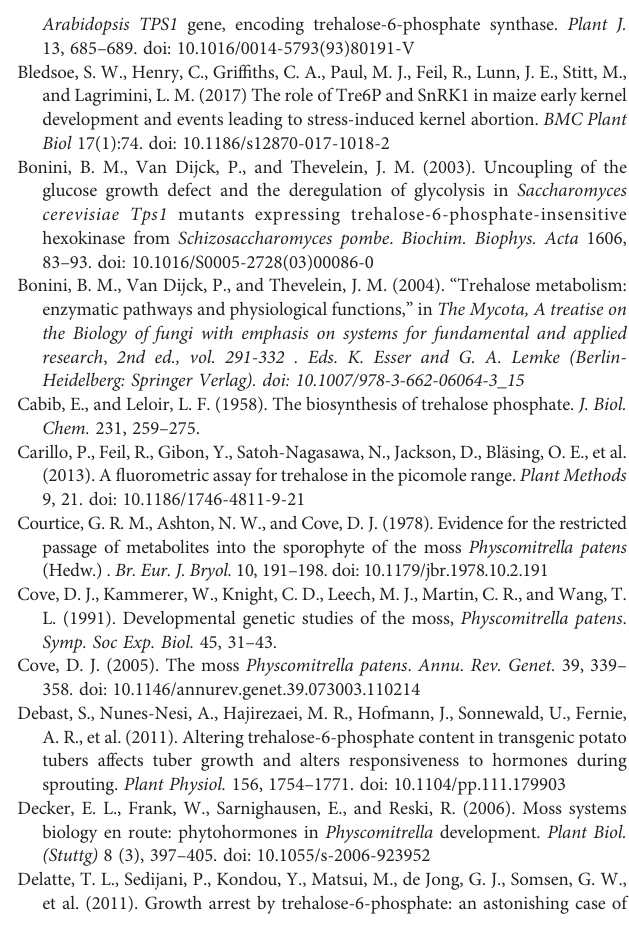
SUPPLEMENTARY TABLE 1 | List of primers used in the study. Abbreviations: FW (forward), RV (reverse), GSP (gene-speci fi c primer), CDS (coding sequence), qPCR (quantitative